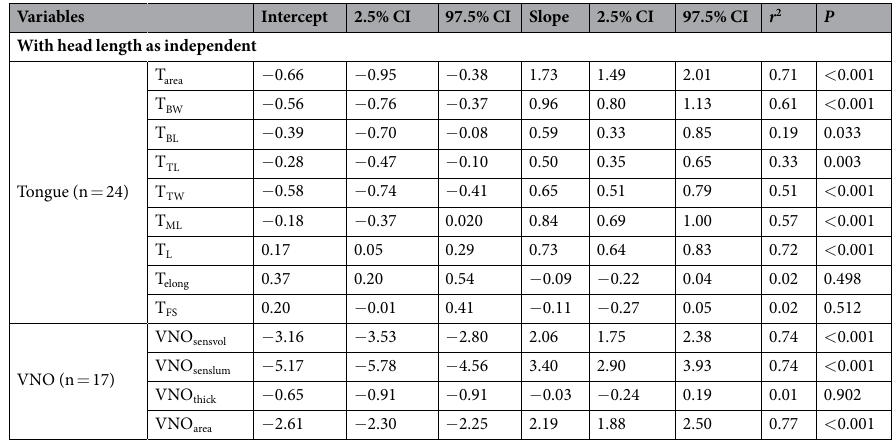
Table 2. Relationships of tongue and vomeronasal organ (VNO) morphometrics with head size in lacertid lizards, obtained through phylogenetic generalised least square (pGLS) regressions. Slopes and intercepts of the confidence intervals (95%) are also